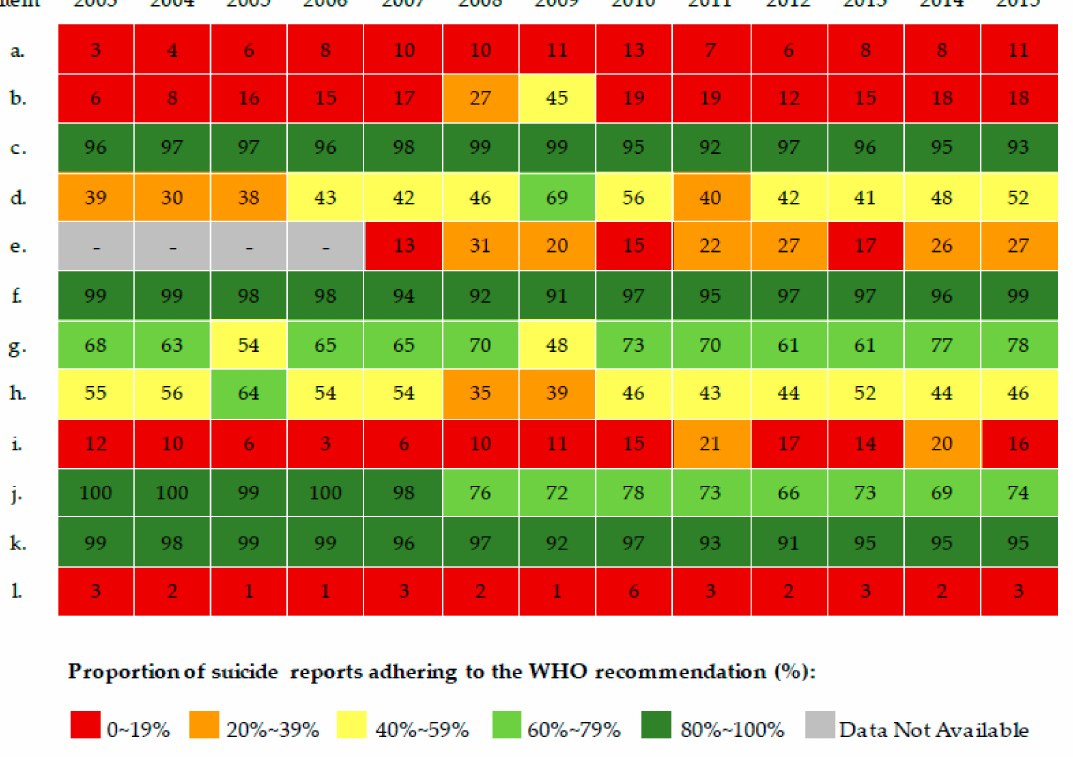
Figure 2. Proportion of suicide news stories applying the WHO recommendations in the top 10 newspapers in China,